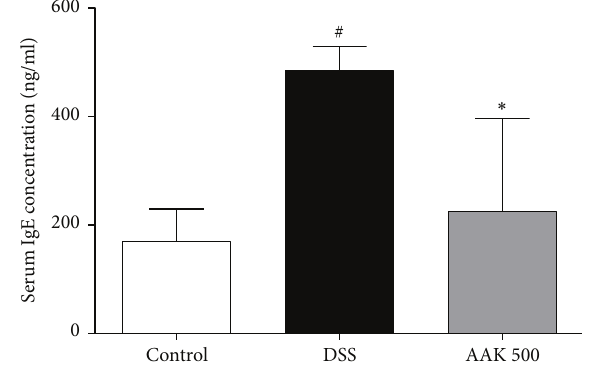
Figure 8: Effects of AAK extract on the concentrations of serum IgE in DSS-induced colitis. Total serum IgE levels were measured by ELISA. Values are expressed as the mean ± SD ( 𝑛 = 4 – 6 per group). # 𝑝 < 0.05 versus control; ∗ 𝑝 < 0.05 versus DSS.